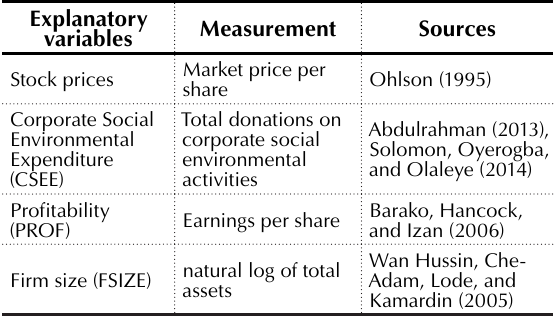
Table 1. Construct of the control variables